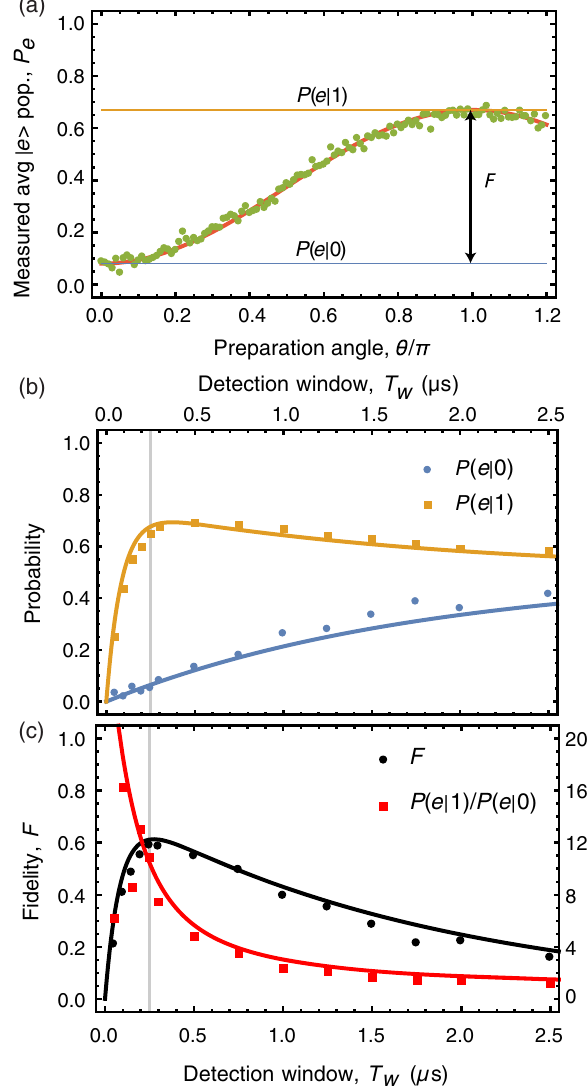
FIG. 3. (a) Measured (averaged readout) excited-state popula- tion of the detection qubit (green dots) as a function of the preparation angle θ of the photon state j γ i , for detection time 250 ns. The red line is a fit to the expected window T w ¼ dependence, with the detection efficiency P ð e j 1 Þ ¼ 65 . 8% (orange) and the dark count probability P ð e j 0 Þ ¼ 5 . 9% (blue line) as parameters. The fidelity F ¼ 59 . 9% is indicated. (b) Dark count probability P ð e j 0 Þ (blue), photon-detection efficiency P ð e j 1 Þ (orange), (c) their ratio P ð e j 1 Þ =P ð e j 0 Þ (red), and the fidelity F (black) vs length of the detection time window T . w Theory lines take into account finite lifetime, losses, and photon line shape (see main text and Appendix D). In the remainder of 250 ns is used the paper, the detection time window with T w ¼ (vertical gray